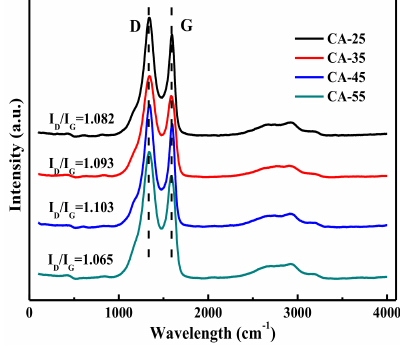
Figure 2. Raman patterns of CA-X